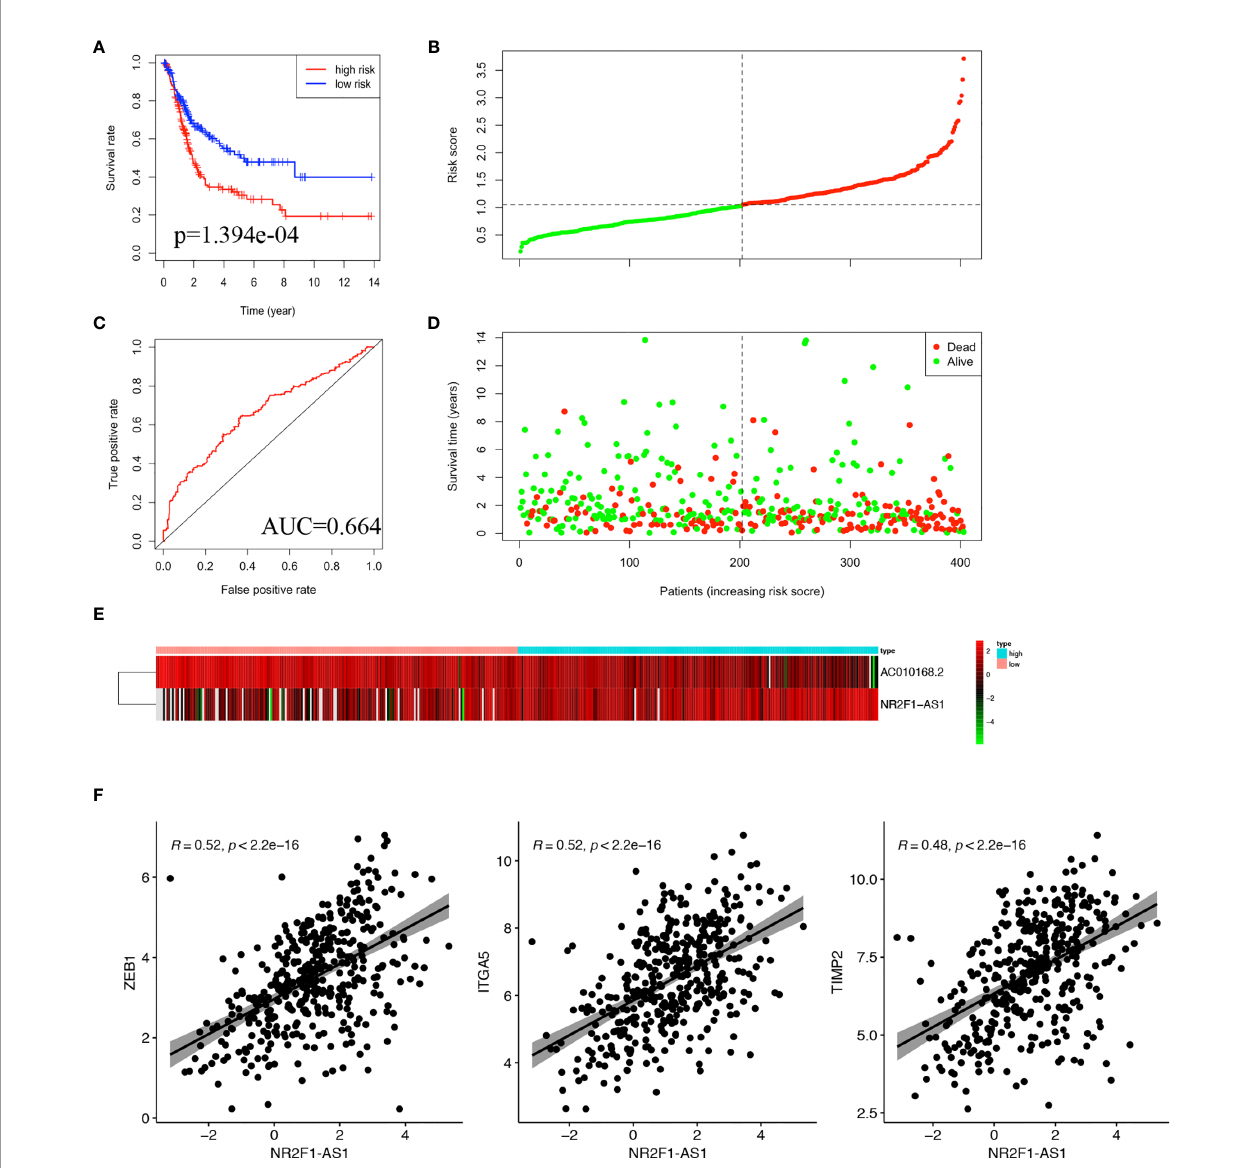
FIGURE 4 | Construction of lncRNA signature in TCGA-BLCA cohort. (A) Kaplan-Meier curve was plotted for overall survival of bladder cancer patients. (B) ROC curve in the high-risk and low-risk groups based on 2-lncRNA signature. (C) Risk score distribution. (D) Survival status distribution. (E) Heatmap of 2 lncRNA in the prognostic model. (F) Pearson correlation analysis between NR2F1-AS1 and ZEB1, ITGA5,